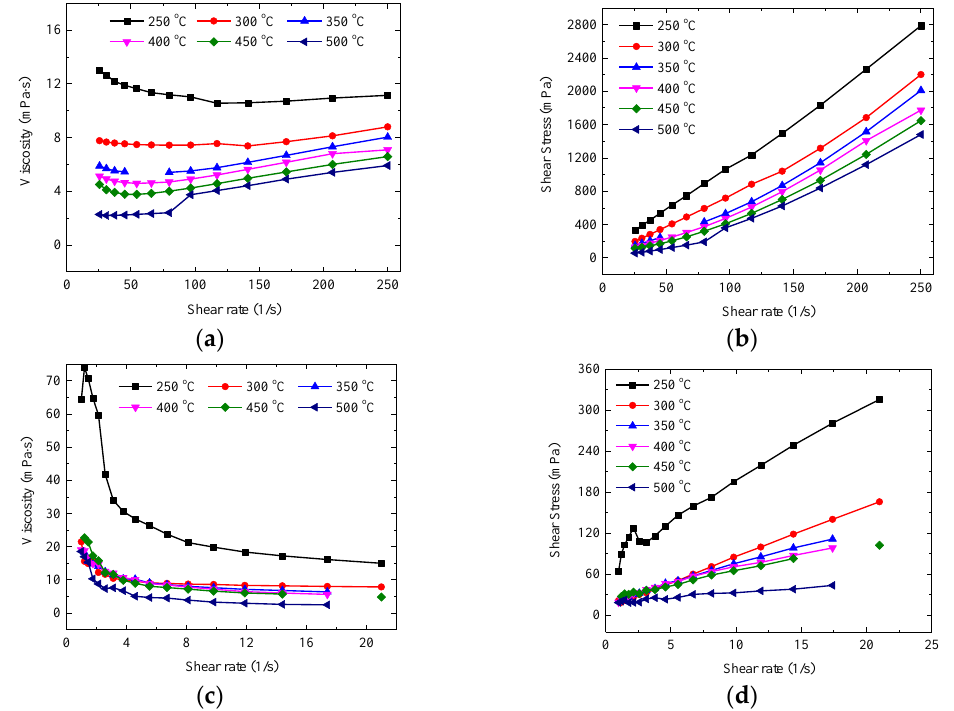
Figure 5. Viscosities and shear stresses against different shear rates for solar salt. ( a ) viscosity (25 s − 1 to 100 s − 1 ), ( b ) shear stress (25 s − 1 to 100 s − 1 ), ( c ) viscosity (1 s − 1 to 25 s − 1 ), ( d ) shear stress (1 s − 1 to 25 s − 1 ).